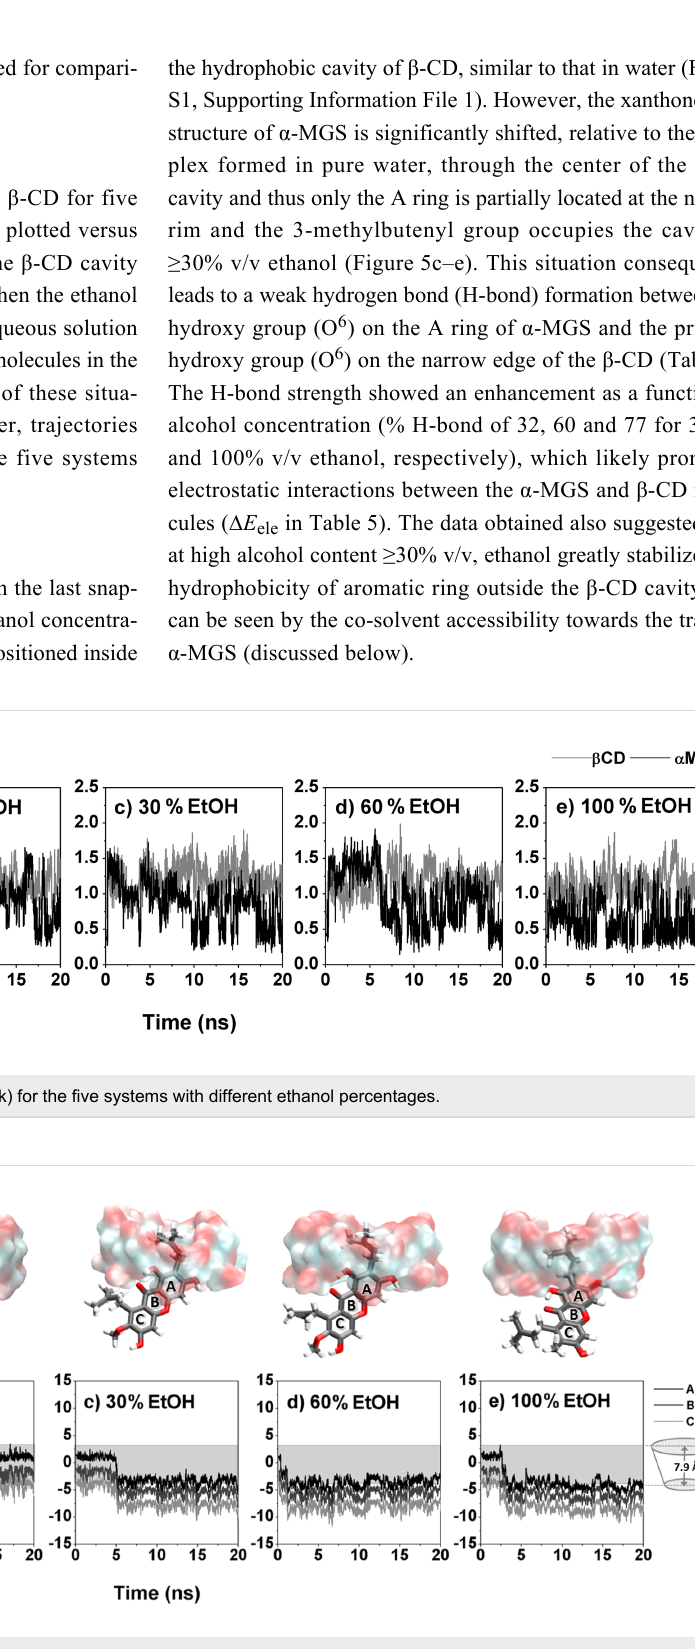
ethanol (5, 15, 30, 60 and 100% v/v) were studied for compari- son with the experimental